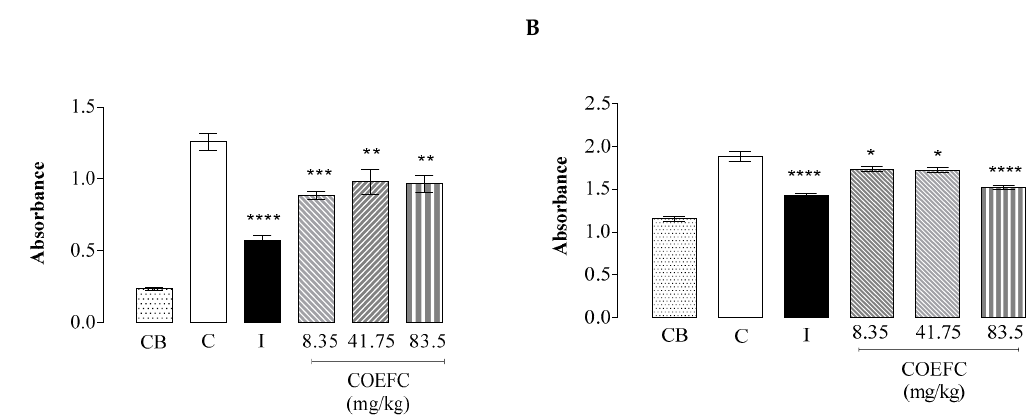
Figure 6. E ff ect of the COEFC (8.35, 41.75, and 83.5 mg / kg / p.o.) relative to vascular permeability by Figure 6. Effect of the COEFC (8.35, 41.75, and 83.5 mg/kg/p.o.) relative to vascular permeability by Evans Blue extravasation ( A ) and quantification of the total proteins (g / dL) ( B ). Vascular permeability Evans Blue extravasation ( A ) and quantification of the total proteins (g/dL) ( B ) . Vascular permeability by Evans Blue extravasation between control (C) (saline—0.1 mL / 10 g / p.o.), baseline (CB) (saline—0.1 by Evans Blue extravasation between control (C) (saline—0.1 mL/10 g/p.o.), baseline (CB) (saline—0.1 mL / 10 g / p.o.), indomethacin (I) (10 mg / kg / s.c.), and COEFC (8.35, 41.75 and 83.5 mg / kg / p.o.). Values mL/10 g/p.o.), indomethacin (I) (10 mg/kg/s.c.), and COEFC (8.35, 41.75 and 83.5 mg/kg/p.o.). Values represent the mean ± S.P.M. ( n = 6 / group). * p < 0.05; ** p < 0.01; *** p < 0.001; **** p < 0.0001 vs. control; represent the mean ± S.P.M. ( n = 6/group). * p < 0.05; ** p < 0.01; *** p < 0.001; **** p < 0.0001 vs. control; Statistical analysis: ANOVA followed by the Dunnett’s test with multiple Statistical analysis: ANOVA followed by the Dunnett’s test with multiple comparisons.